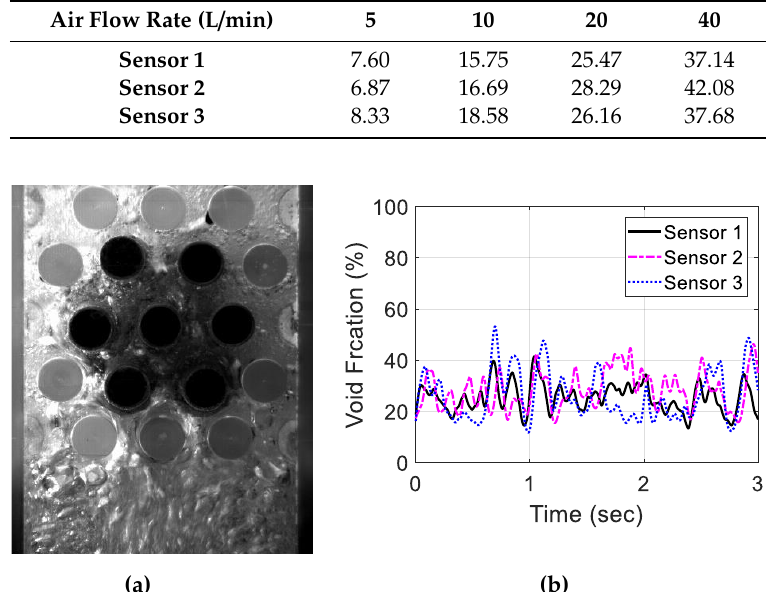
Table 3. Average void fraction data for di ff erent air flow rates using the three-sensor configuration.